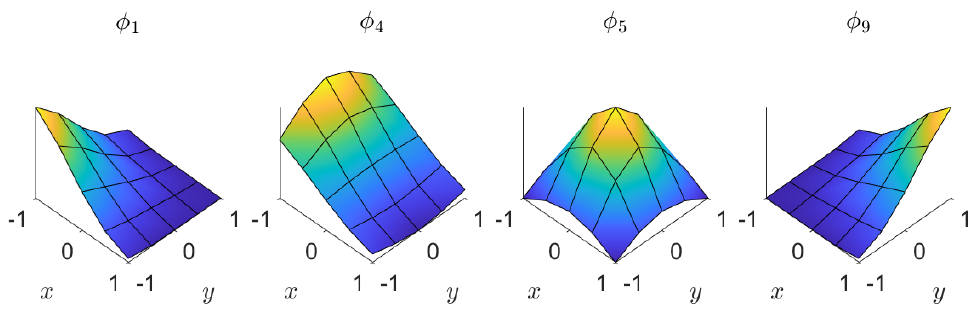
Figure 2. Sample of shape functions generation for a reference unitary domain.